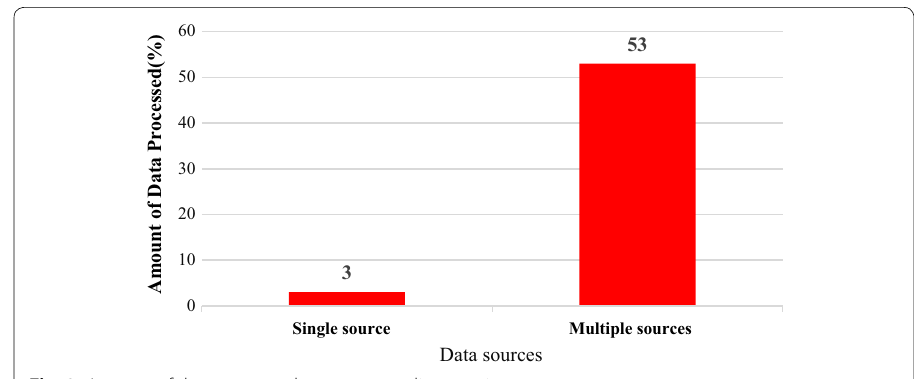
Fig. 3 Amount of data processed to meet sampling